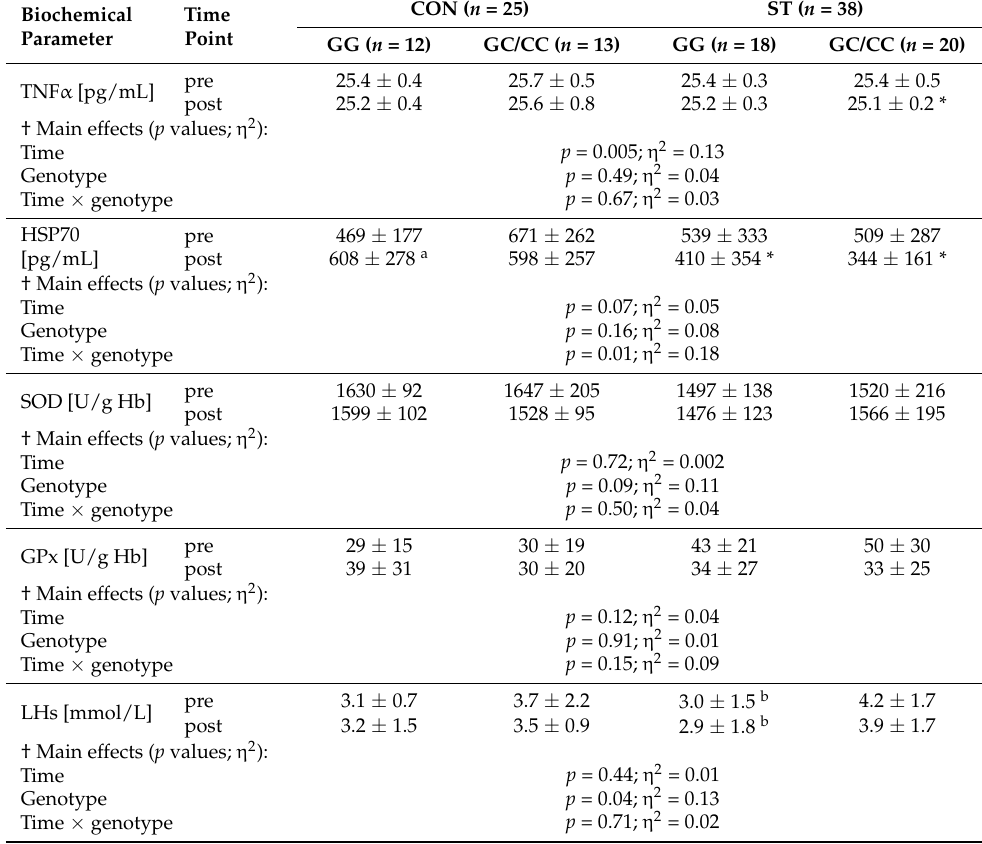
Table 5. Biochemical parameters in blood prior to (pre) and after (post) 12-week in the control (CON) and swimming training (ST) group; the results stratified according to HSPA1A gene polymorphism. Biochemical